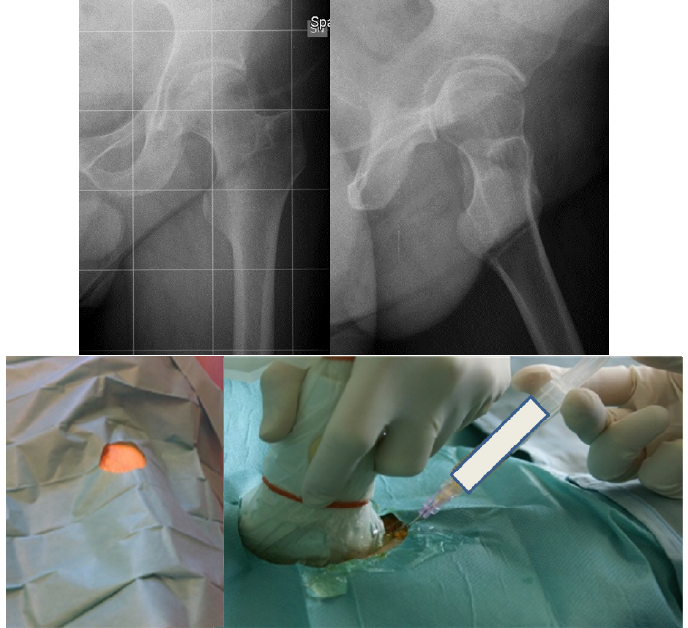
Figure 2. Radiograms of a forty-eight-year-old haemophilic subject affected by severe haemophilia A with symptomatic left hip arthropathy treated by hyaluronic acid intraarticular injections in a sterile procedure.